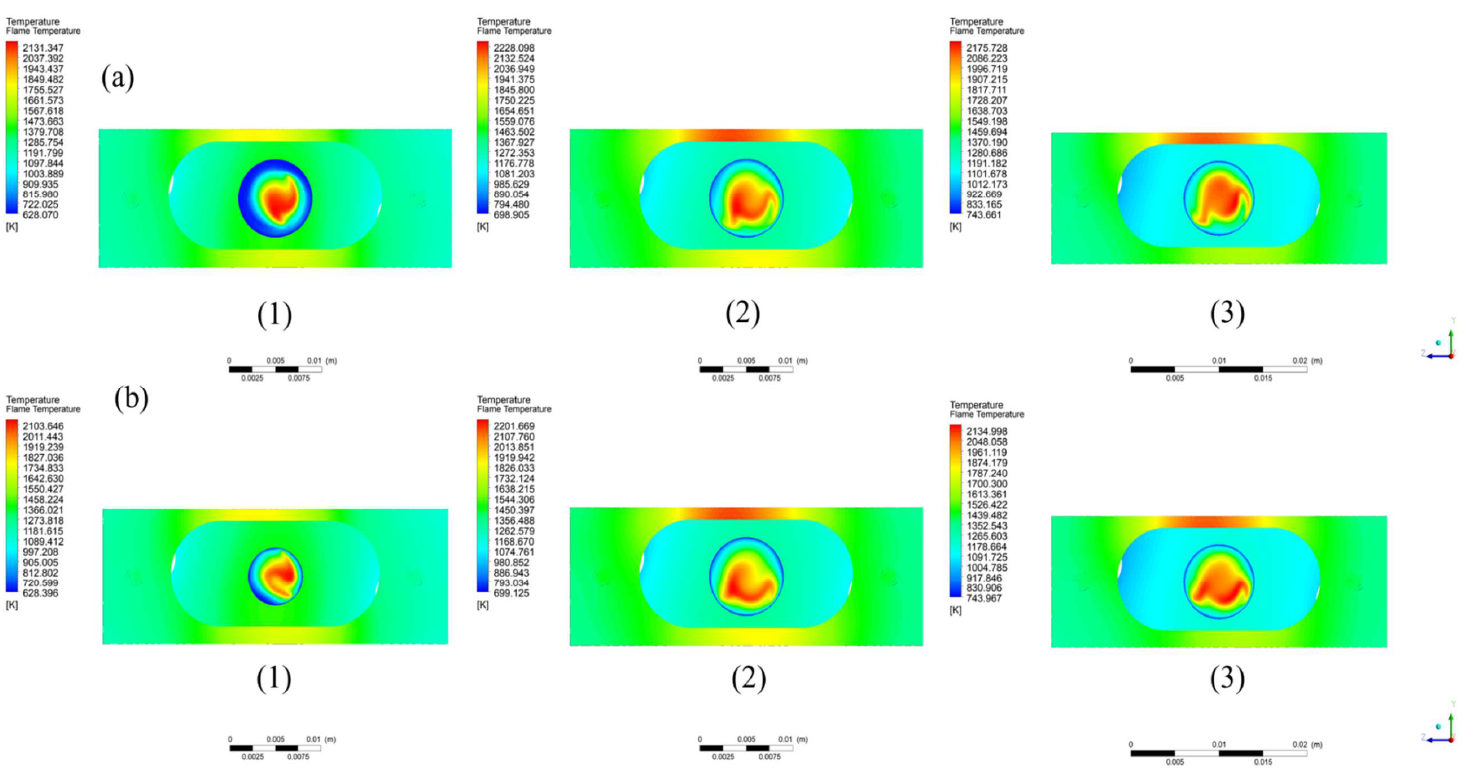
Figure 12. The vertical horizontal combustor flame temperatures for ( a ) aluminum and ( b ) stainless steel material with fuel velocity 0.2; ( 1 ) air velocity 0.6, ( 2 ) air velocity 1.0, and ( 3 ) air velocity 1.4 m/s .